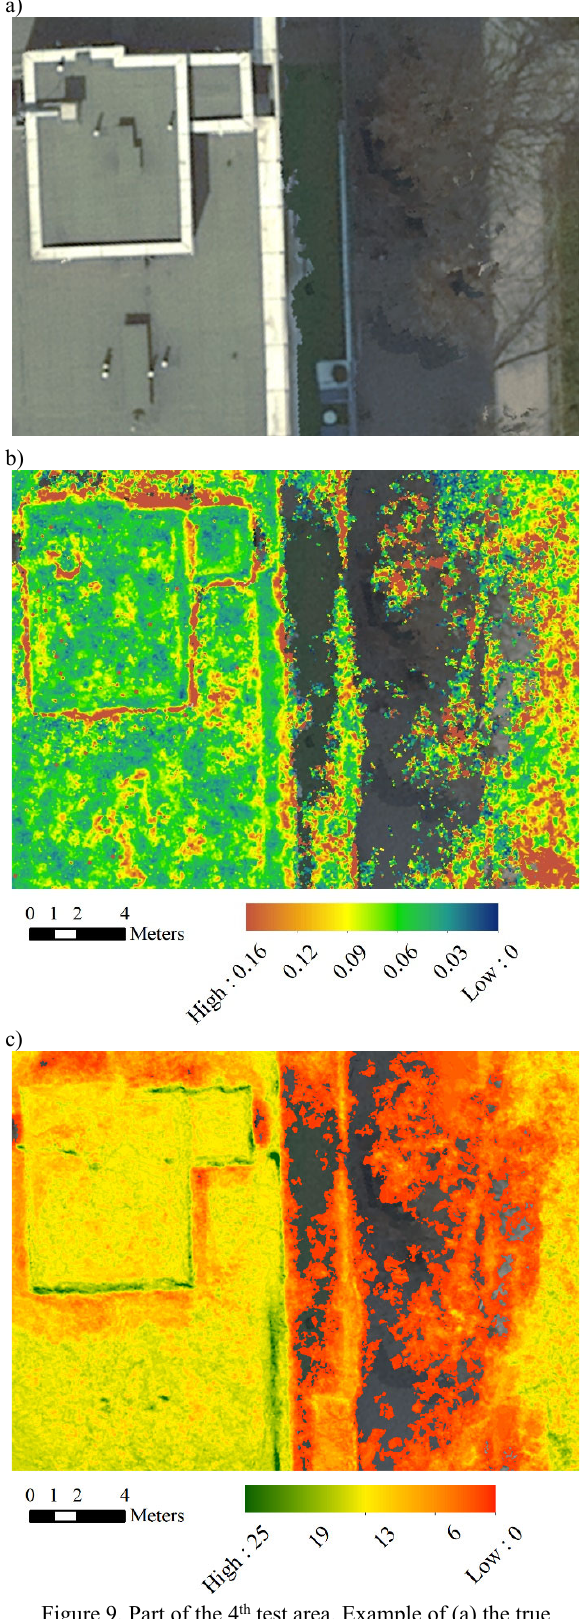
Figure 9. Part of the 4 th test area. Example of (a) the true orthophoto artefact on a building edge together with (b) the DSM Standard Deviation layer (in meters) and the Point Density layer (3D points per DSM